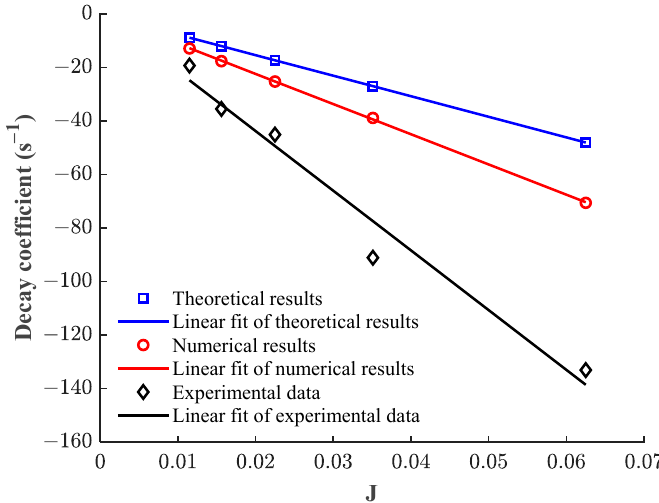
Figure 2. Comparison of decay coefficients obtained by three different methods.